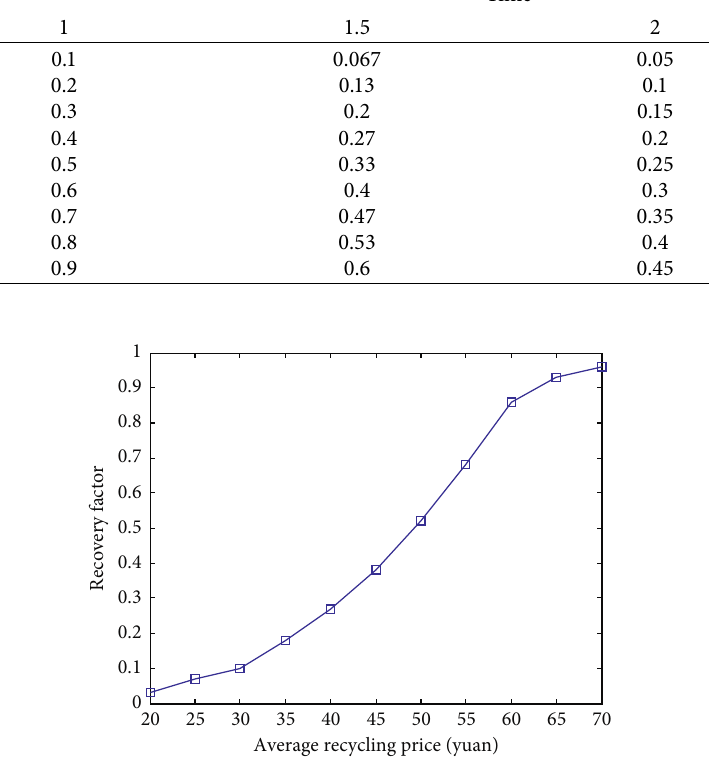
Figure 13: Recycling factor and average recycling price table function.